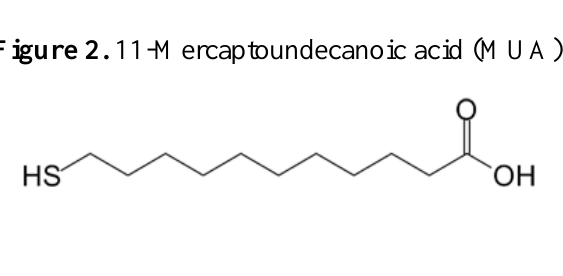
Figure 1. 4-Mercapto-1-butanol (MB).